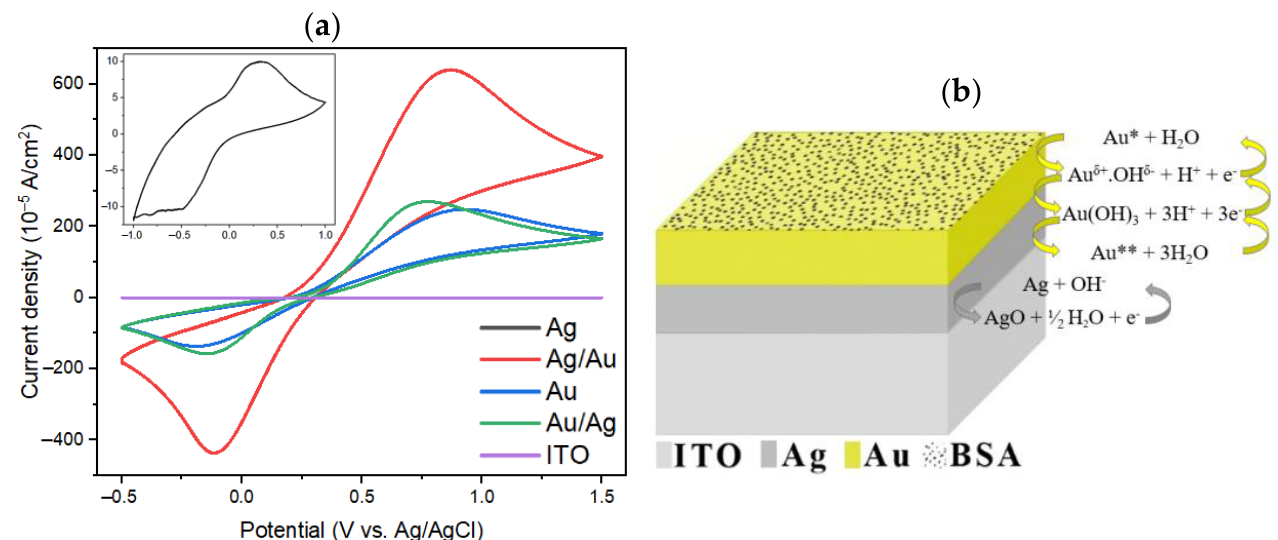
Figure 4. ( a ) The results of the CV test of the various thin films without the deposition of BSA with a scan rate of 100 mV/s (small picture is CV test of Ag thin film); ( b ) the oxidation and reduction reactions on the thin films.